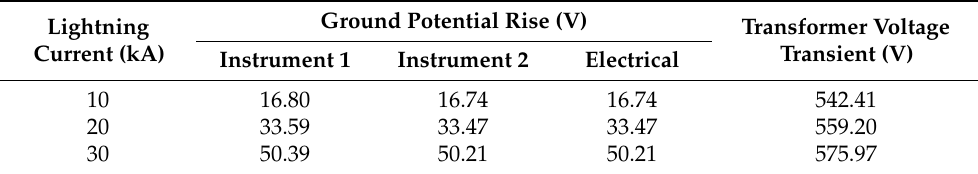
Table 6. Potential rise due to GPR on the system of the equipotential grounding system with SPD.